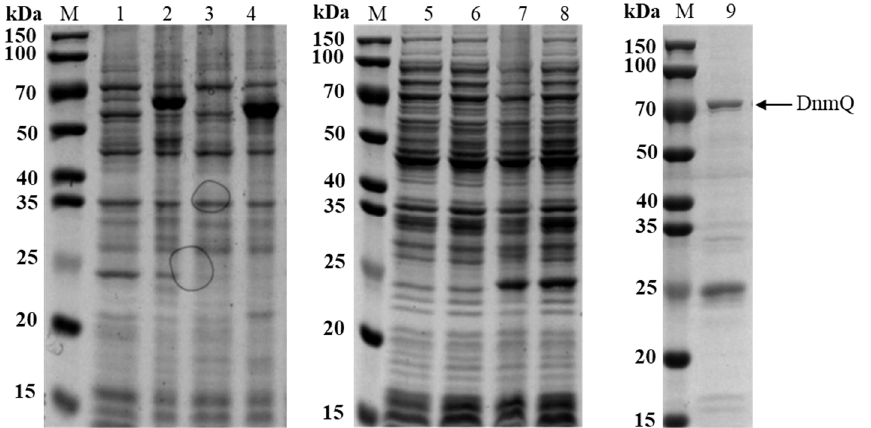
Figure 2. The expression of DnmQ in different expression vectors and hosts. Lane 1, 22bQ/DE3 induced supernatant; Lane 2, 22bQ/DE3 induced total protein; Lane 3, 22bQ/RIL induced supernatant; Lane 4, 22bQ/RIL induced total protein; Lane 5, 32aQ/DE3 induced supernatant; Lane 6, 32aQ/DE3 induced total protein; Lane 7, 32aQ/RIL induced supernatant; Lane 8, 32aQ/RIL induced total protein; and Lane 9, DnmQ purified from 32aQ/DE3; M, protein marker (Genestar, 15, 20, 25, 35, 40, 50, 70, 100 and 150 kDa.).